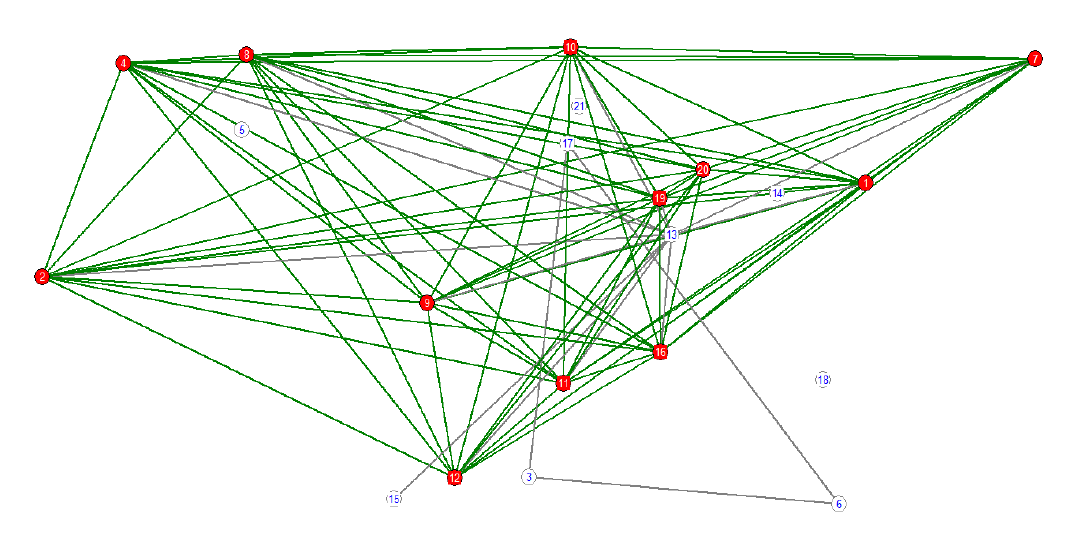
Figure 5. Finding the maximum clique in the graph (an